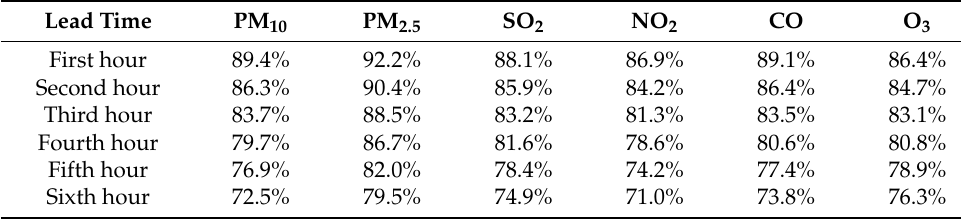
Table 18. The accuracies of the LSTM_HPO for 6 h in dataset 2. Lead Time